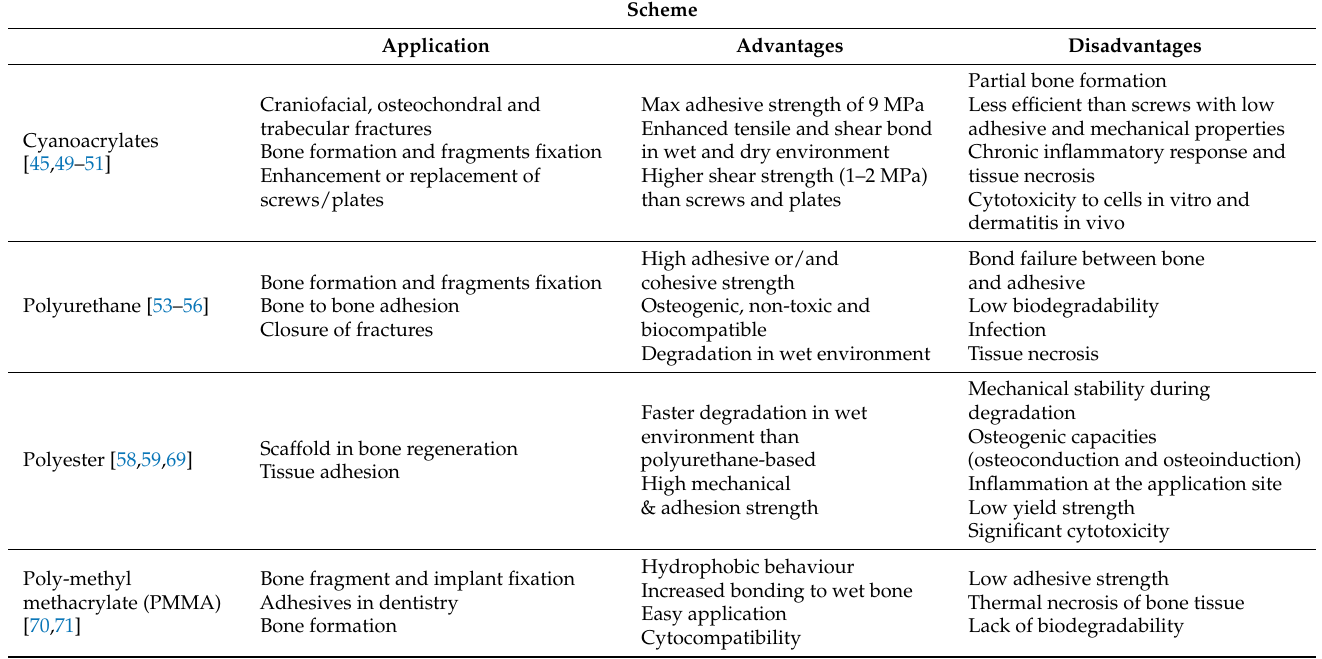
Table 1. Comparison of the different properties of all the synthetic-based